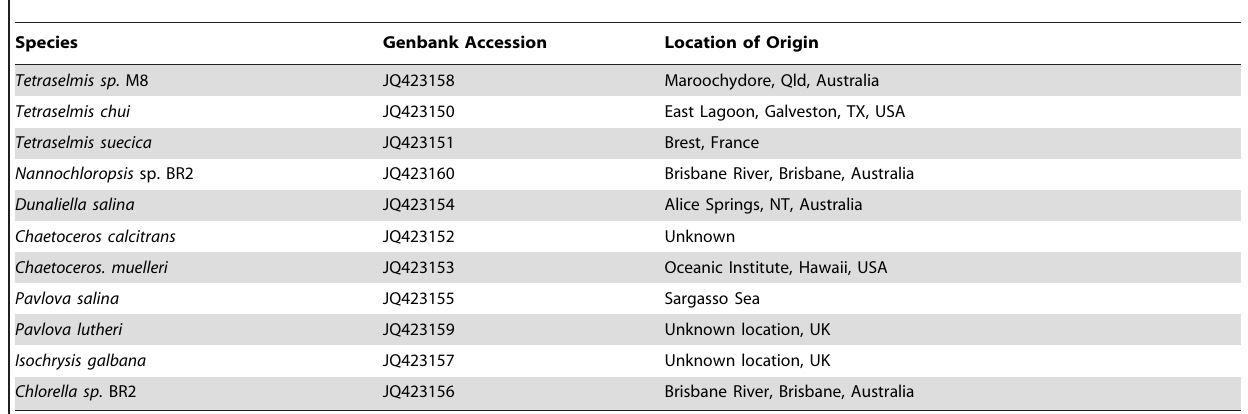
Table 1. Sources and 18S rRNA sequence accessions of microalgae strains used in this